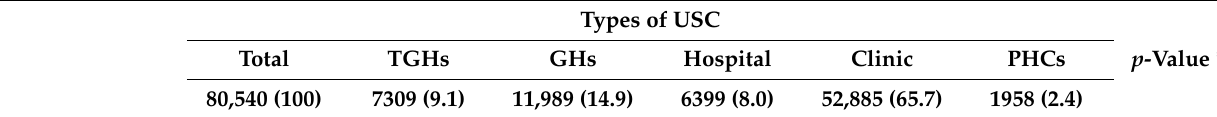
Table 1. Patient Characteristics and Outpatient Care Use by Usual Source of Care (USC)